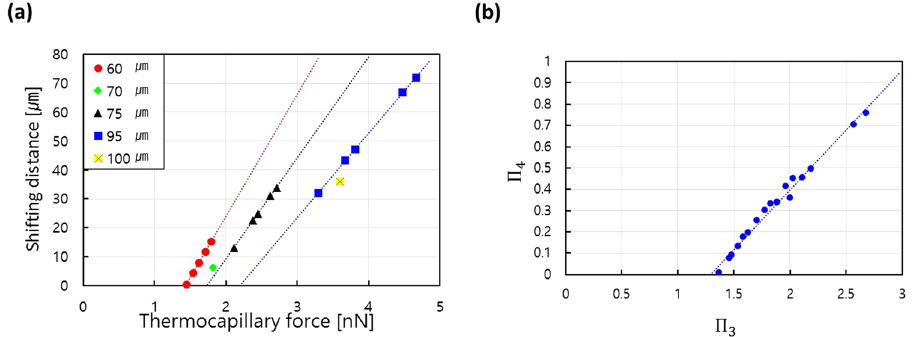
Figure 3. The relation between thermocapillary force and shifting distance. ( a ) The shifting distance is linearly proportional to thermocapillary force as the laser power is increased from 70 to 110 mW. The dotted lines represent a linear fit where the R 2 value is nearly 1. ( b ) The non-dimensionalized thermocapillary force ( Π 3 ) and shifting distance ( Π 4 ) show a linear relation; all points appear on a single line with an R 2 value of 0.9863. The slope of the dotted line is 0.5603, and the intercept of the horizontal axis occurs at